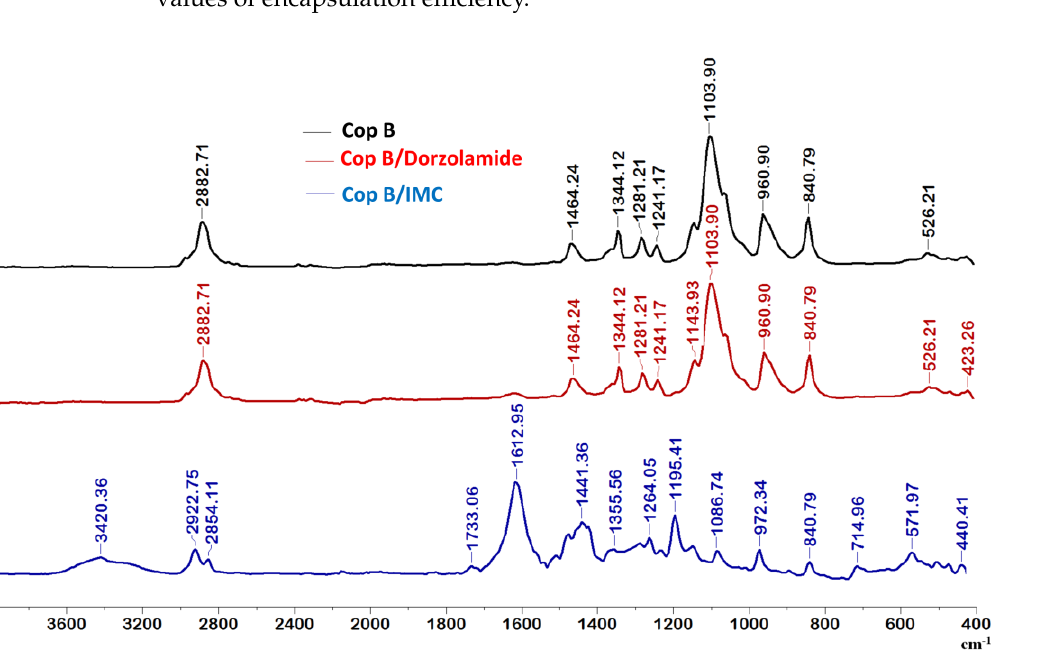
Figure 3. FTIR spectra of free and drug-loaded PMs at a copolymer/drug ratio of 10/1.